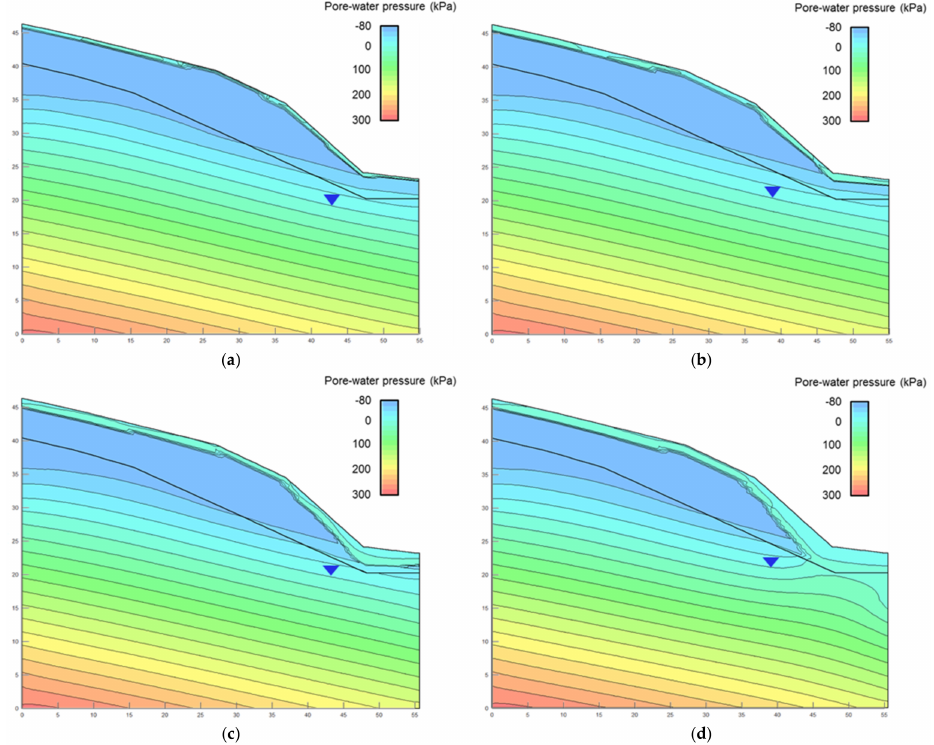
Figure 5. Pore-water pressure change with time in 2016 (Da-Dong-Shan rainfall station, 14.5 mm/h):